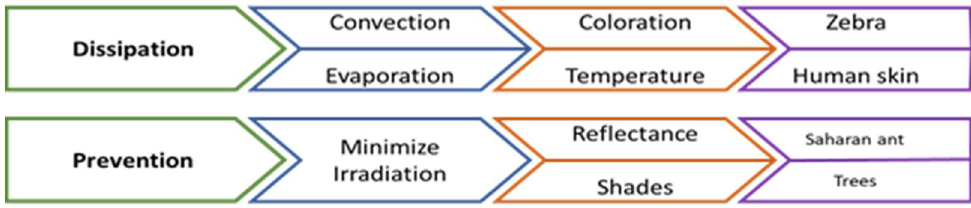
Figure 5. Selected exploration model paths for each design challenge: dissipation and prevention. Own elaboration.